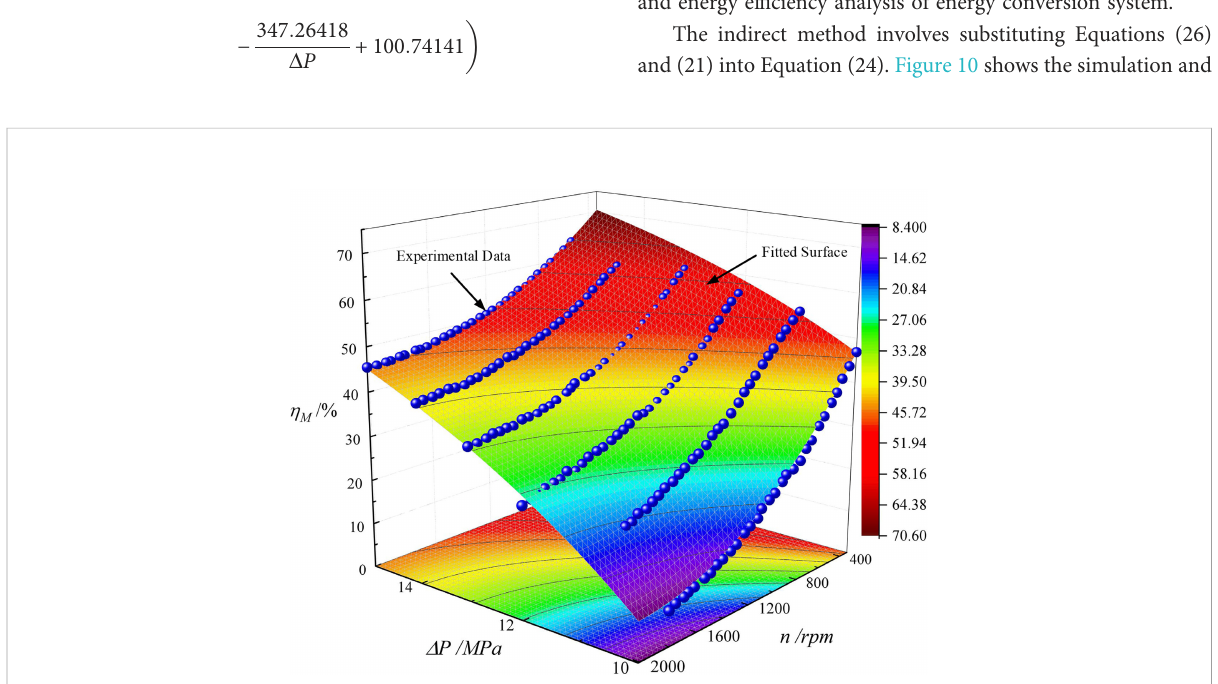
FIGURE 8 The experimental data and fi tting results for mechanical ef fi ciency of hydraulic